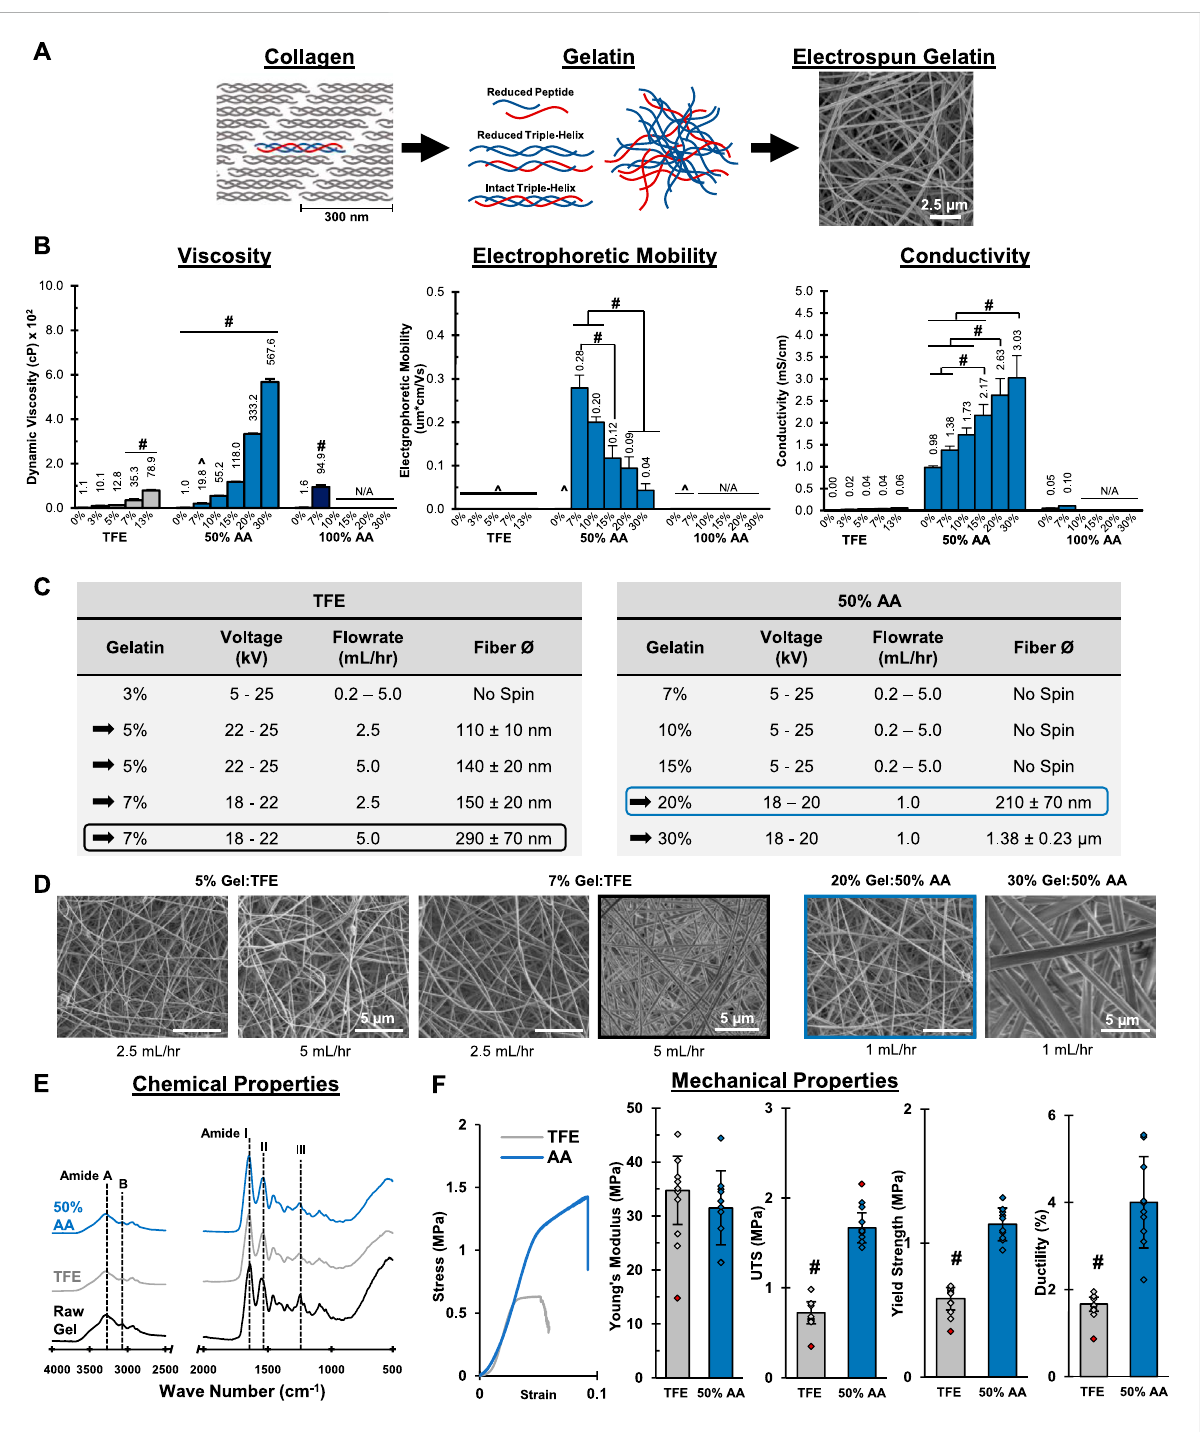
FIGURE 1 Mesh Fabrication: Solvent Optimization and Electrospinning. 50% acetic acid (AA) dissolves gelatin and supports mesh fabrication by electrospinning. The resulting mesh morphology, chemical composition and mechanical properties are comparable to meshes prepared in tri fl uoroethanol (TFE). (A) A schematic representing the structure of gelatin and its relationship to collagen. (B) Dynamic viscosity, electrophoretic mobility and conductivity measurements for gelatin solutions ( n = 3). ^ = Below Limit of Detection for Instrument. N/A = Not available due to sample gelling before analysis. (C) Successful electrospinning parameters using TFE and 50% AA. (D) Fiber morphology and diameter ( n = 50) for meshes prepared from stable electrospins identi fi ed in part c. (SEM. 5,000x). (E) Chemical composition (FTIR-ATR). (F) Mesh tensile properties ( n = 10). Red markers indicate sample outliers. #= p <